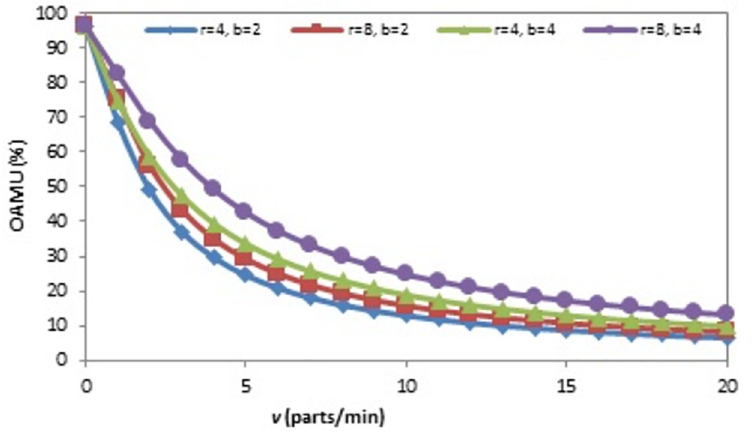
Fig 7. OAMU-v diagram for single-machine FMC.